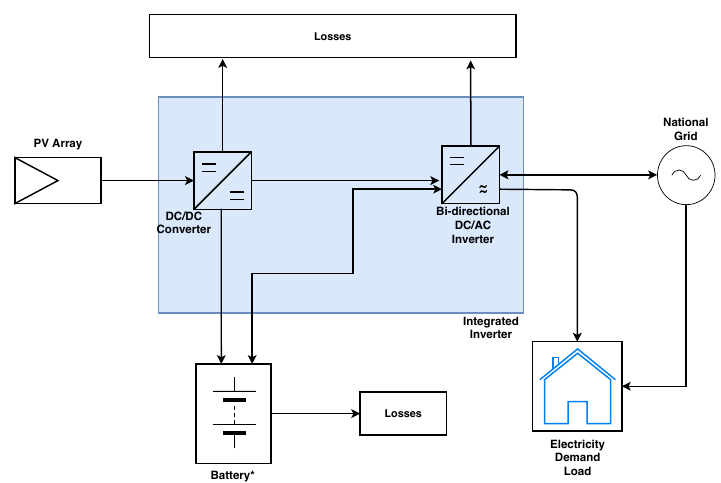
Figure 3. DC-coupled PV-battery system with integrated inverter used in this study. Arrows indicate the direction of possible energy flows between the individual components. Table 2. Values selected for the technical and economic assessment of PV-coupled battery systems. The cycle aging factor is given for a 100%